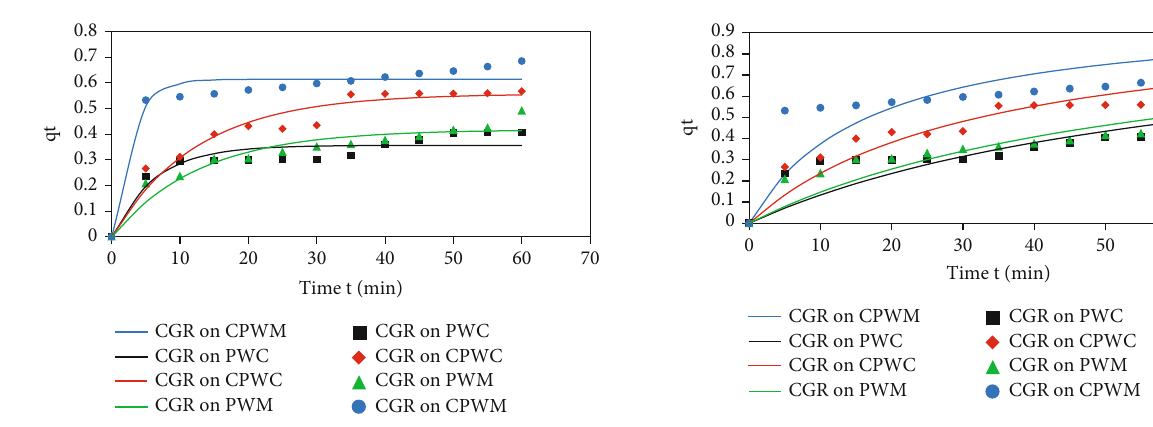
Figure 17: Nonlinear pseudo fi rst-order kinetic study. Table 4: Nonlinear comparative study of kinetic parameters for detoxi fi cation of CGR. Kinetic adsorption